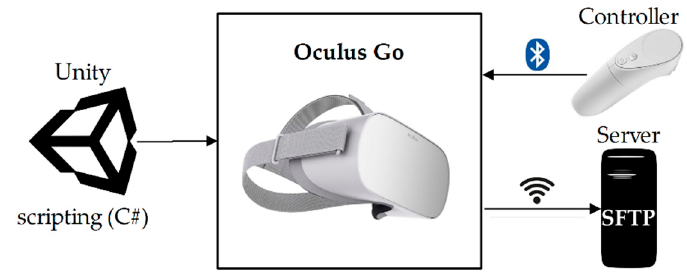
Figure 2. Components of the immersive virtual reality application.